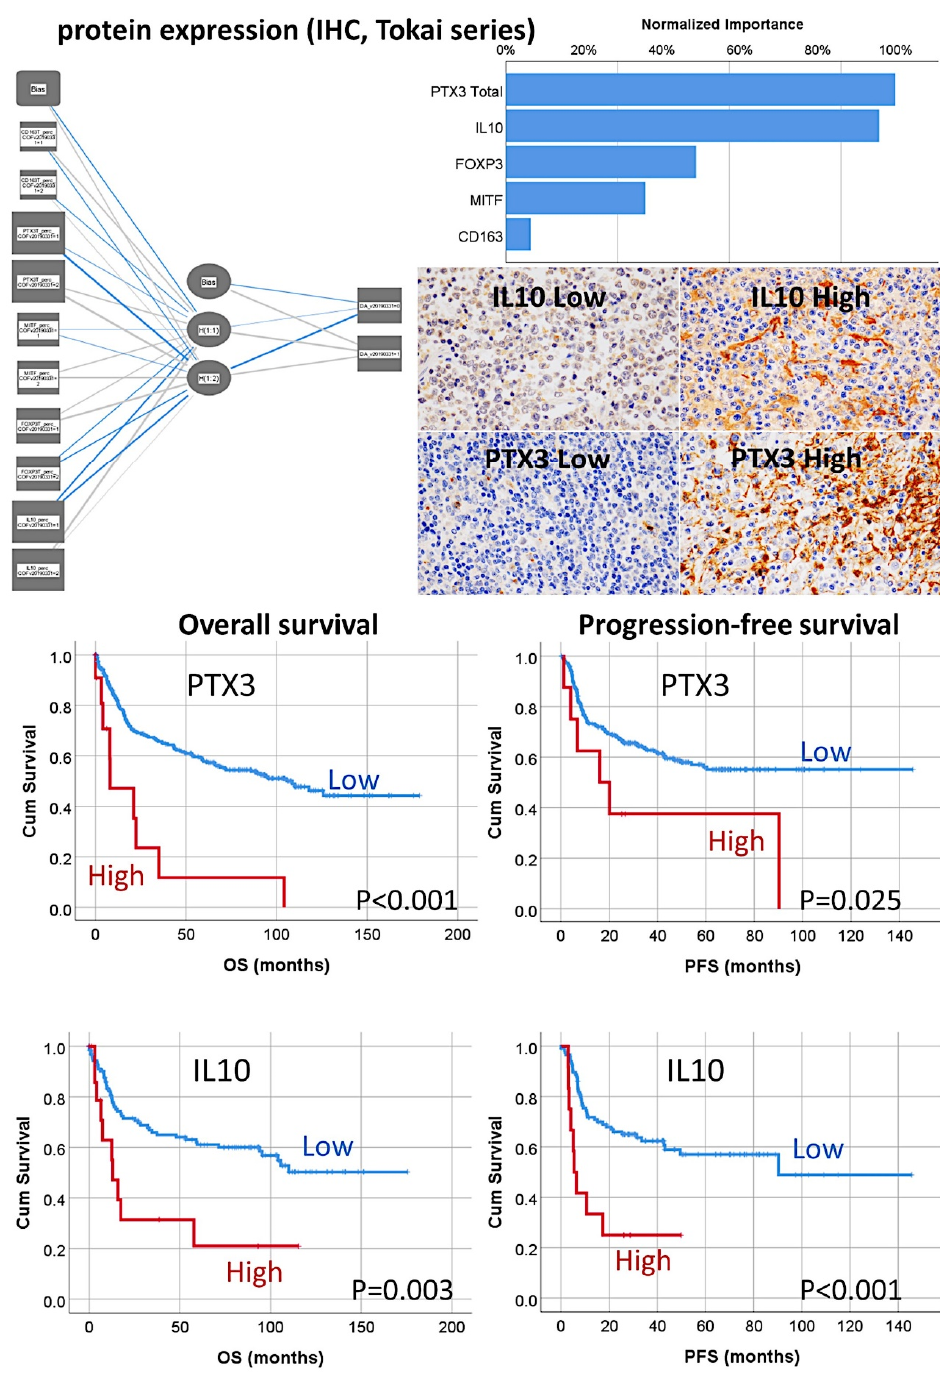
Figure 22. Prediction of the overall survival of diffuse large B-cell lymphoma by M2c-like macrophages using an artificial neural network. The overall survival of the patients was predicted using an artificial neural network using the histochemical data of the tissue samples. The network confirmed that the most relevant markers were PTX3 and IL10, which characterized the immune regulatory M2c-like macrophages. A conventional survival analysis using the Kaplan–Meier with log-rank test confirmed the association of high M2c-like macrophages with poor overall and progression-free survival of the patients. Original magnification: 400×.